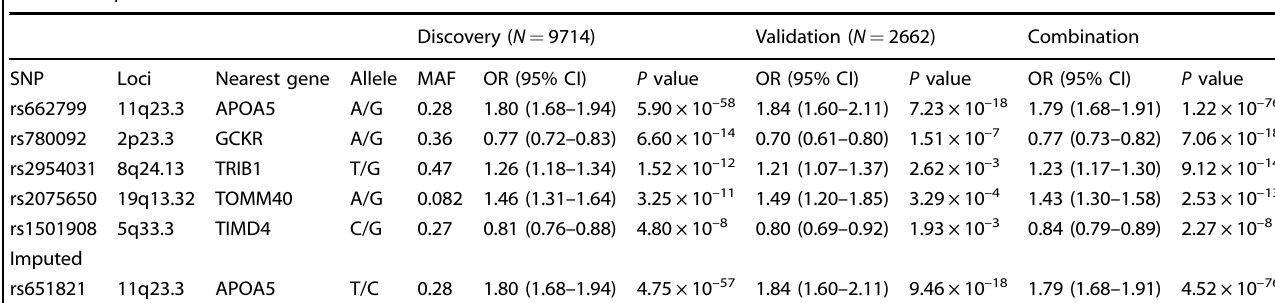
Fig. 1 Genome-wide analysis for hyperlipidemia. a Manhattan plot of results for the association between SNPs and hyperlipidemia risk. b Q-Q plot. The two horizontal lines in the Manhattan plot represent P = 1 × 10 − 5 (lower) and 5 × 10 − 8 (upper). The estimated in fl ation factor ( λ ) was 1.019 for the GWAS. Table 1. Top fi ve lead variants identi fi ed in the